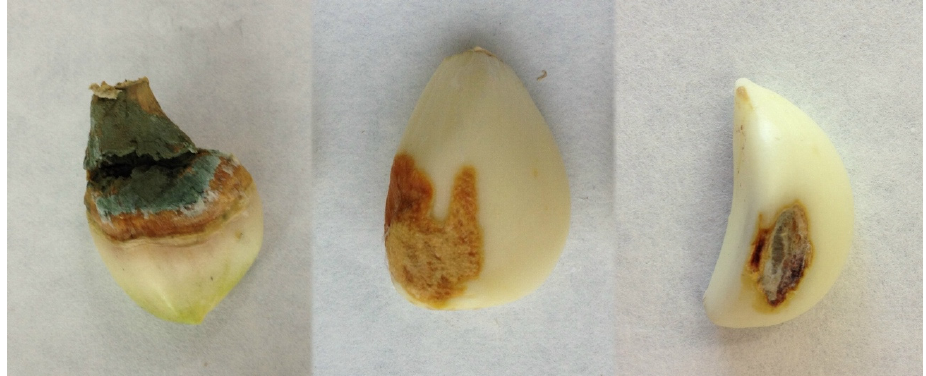
Figure 2. Symptoms associated with fungal species isolated from garlic cloves collected in Spain. Dry rot ( left ), green rot ( middle ), and wounded damage ( right ).